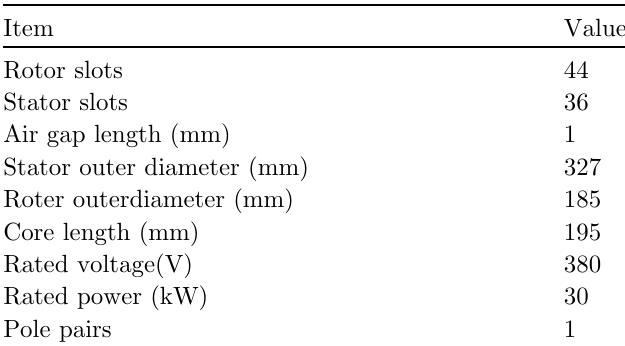
Table 2. Parameters of the motor.